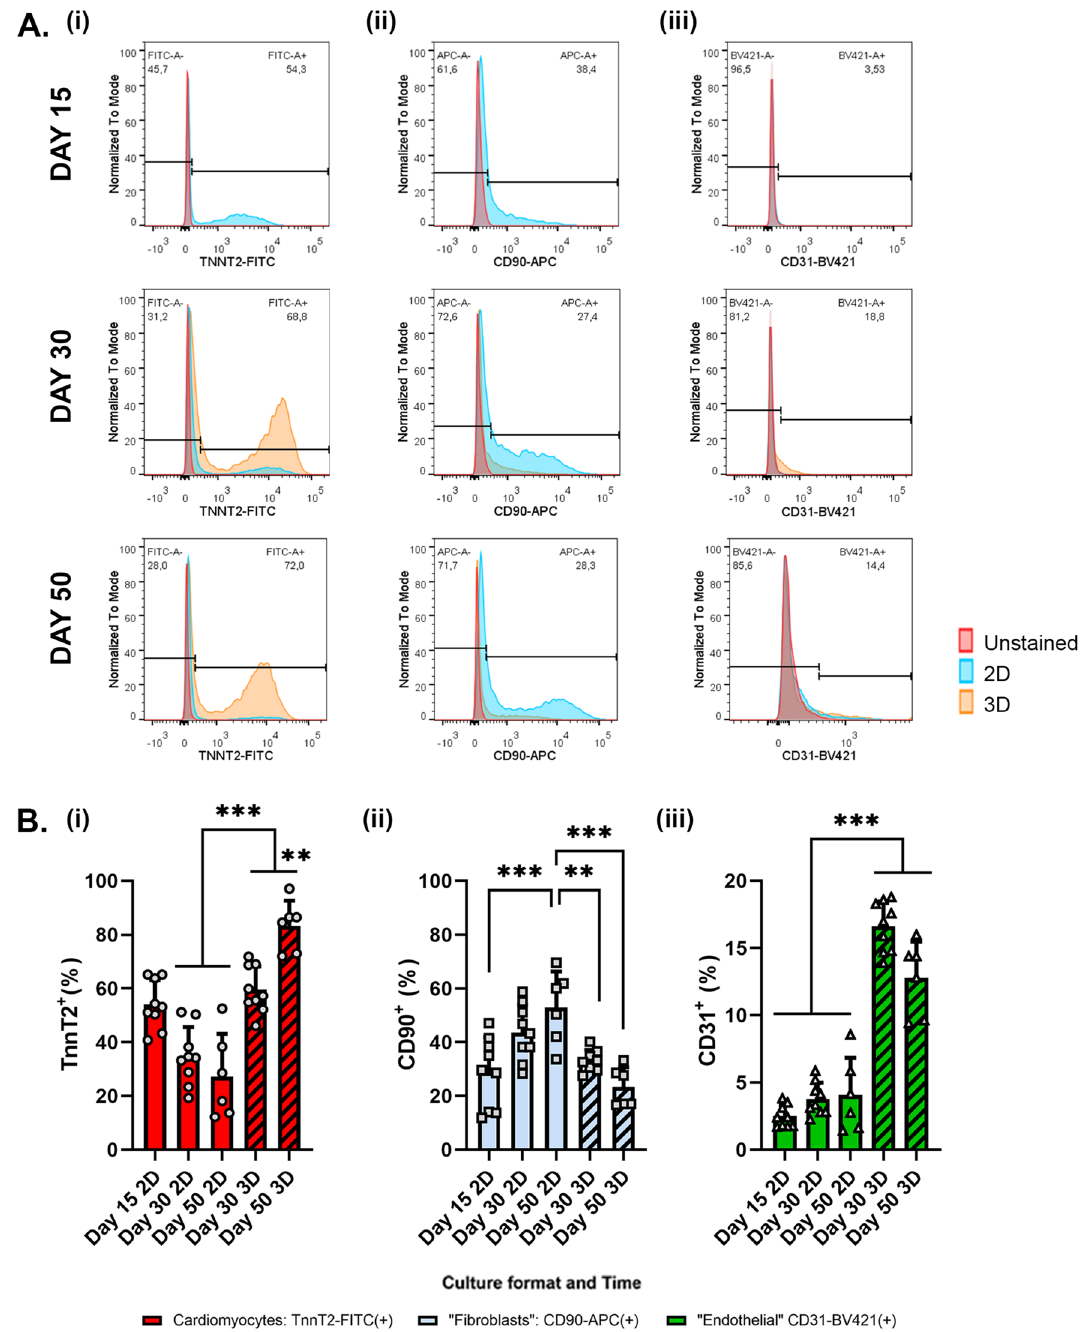
Figure 2. Long-term 3D cultures of hOCMTs contain multiple cardiac cell populations. ( A ) Representative flow cytometry histograms for analysis of cardiac cell types on day 15, day 30 and day 50, with a comparison of 2D and 3D cultures. (i) Cardiomyocytes (TNNT2-FITC), (ii) “Fibroblasts” (CD90-APC), (iii) Endothelial cells (CD31-BV421). Red group represents unstained cells, blue group represents 2D cultures, and orange group represents 3D long-term cultured microtissues, and the gating with the black line depicts the percentage of populations for 3D long-term cultured microtissues. ( B ) Composite average of cardiac cell populations from all flow cytometry experiments: (i) Cardiomyocytes (TNNT2-FITC + %), (ii) “Fibroblasts” (CD90-APC + %), (iii) Endothelial cells (CD31-BV421 + %), on day 15, day 30 and day 50, with a comparison of 2D and 3D cultures. The percentage indicates the positive cells versus total cells (mean ± SD obtained in three independent analyses, n = 9 per condition, Tukey’s multiple comparisons